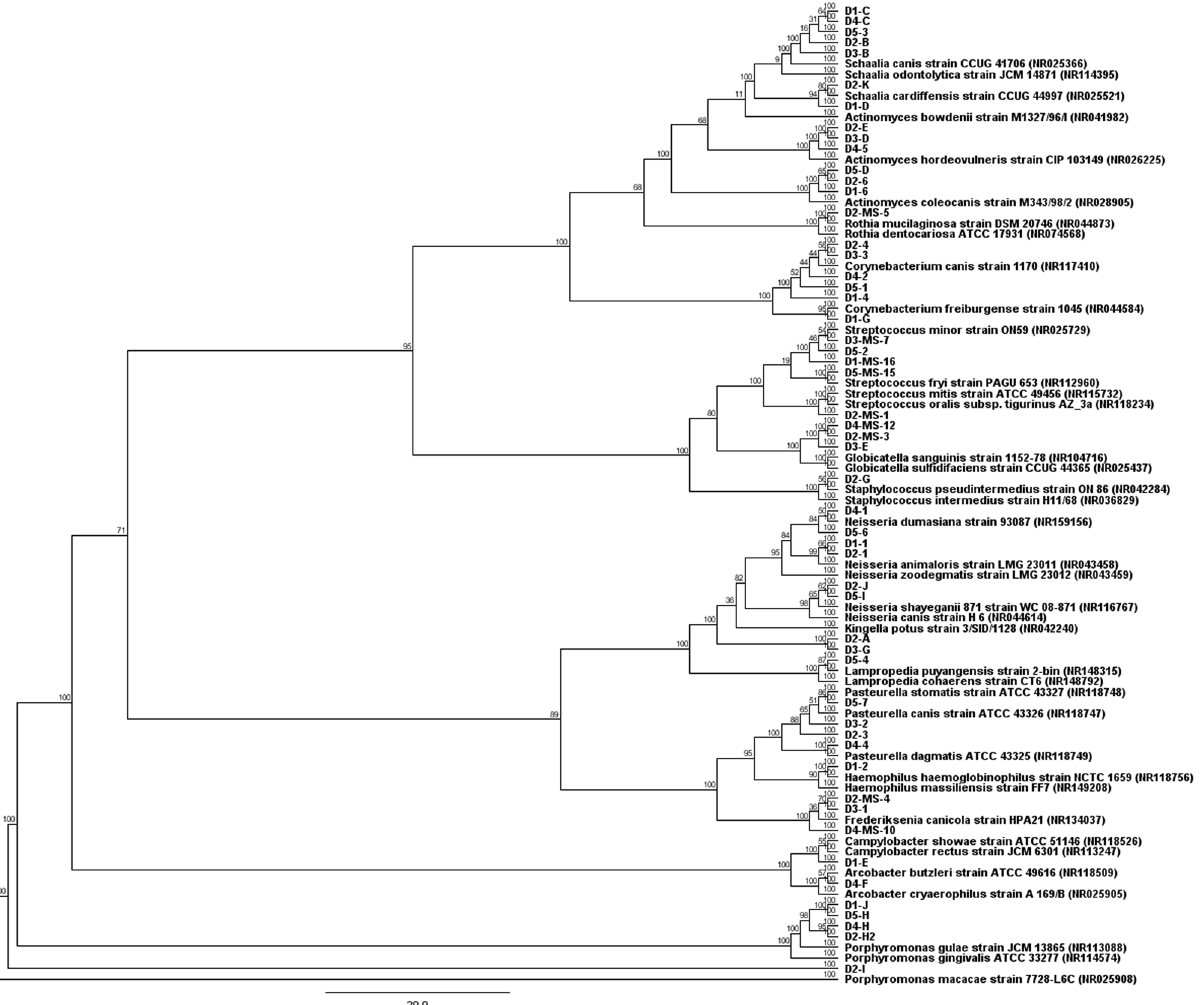
Figure 1. Phylogenetic tree of selected bacterial strains isolated from canine dental biofilms. Phylogenetic tree was made using the neighbor joining method, with 100 bootstrap replicates. Designations D1 to D5 indicate individual dogs, MS indicate Mitis Salivarius agar and numbers indicate individual isolates. The GenBank accession numbers for sequences obtained from the NCBI database are shown in